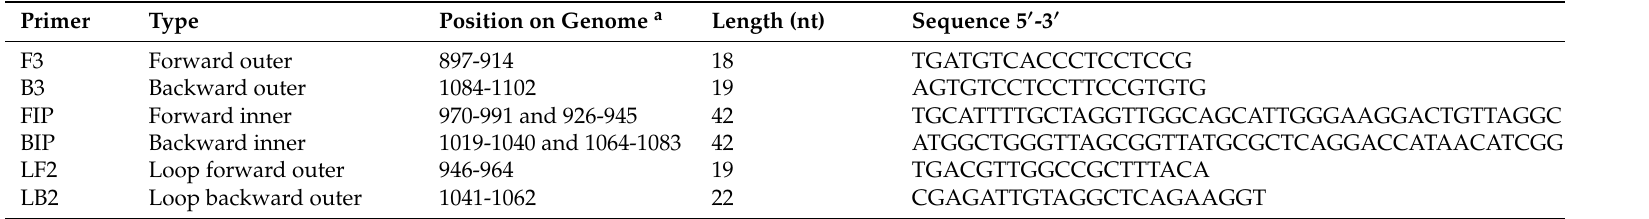
Table 3. Primer set TuYV4-ORF1 used for loop-mediated isothermal amplification of Turnip yellows virus (TuYV).